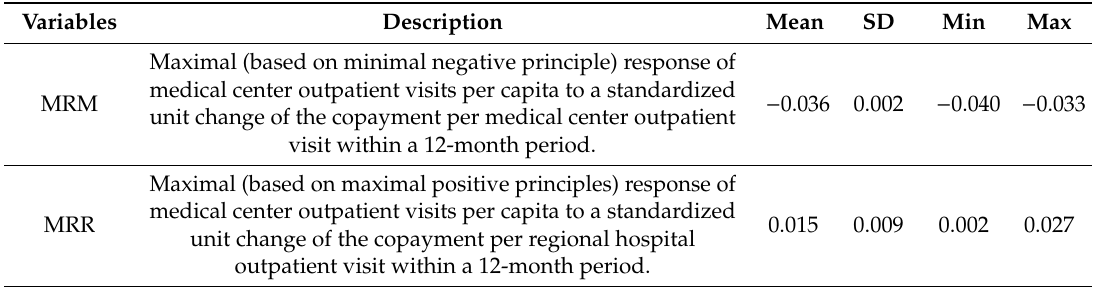
Table 2. Descriptive statistics for the multiple linear regression model †